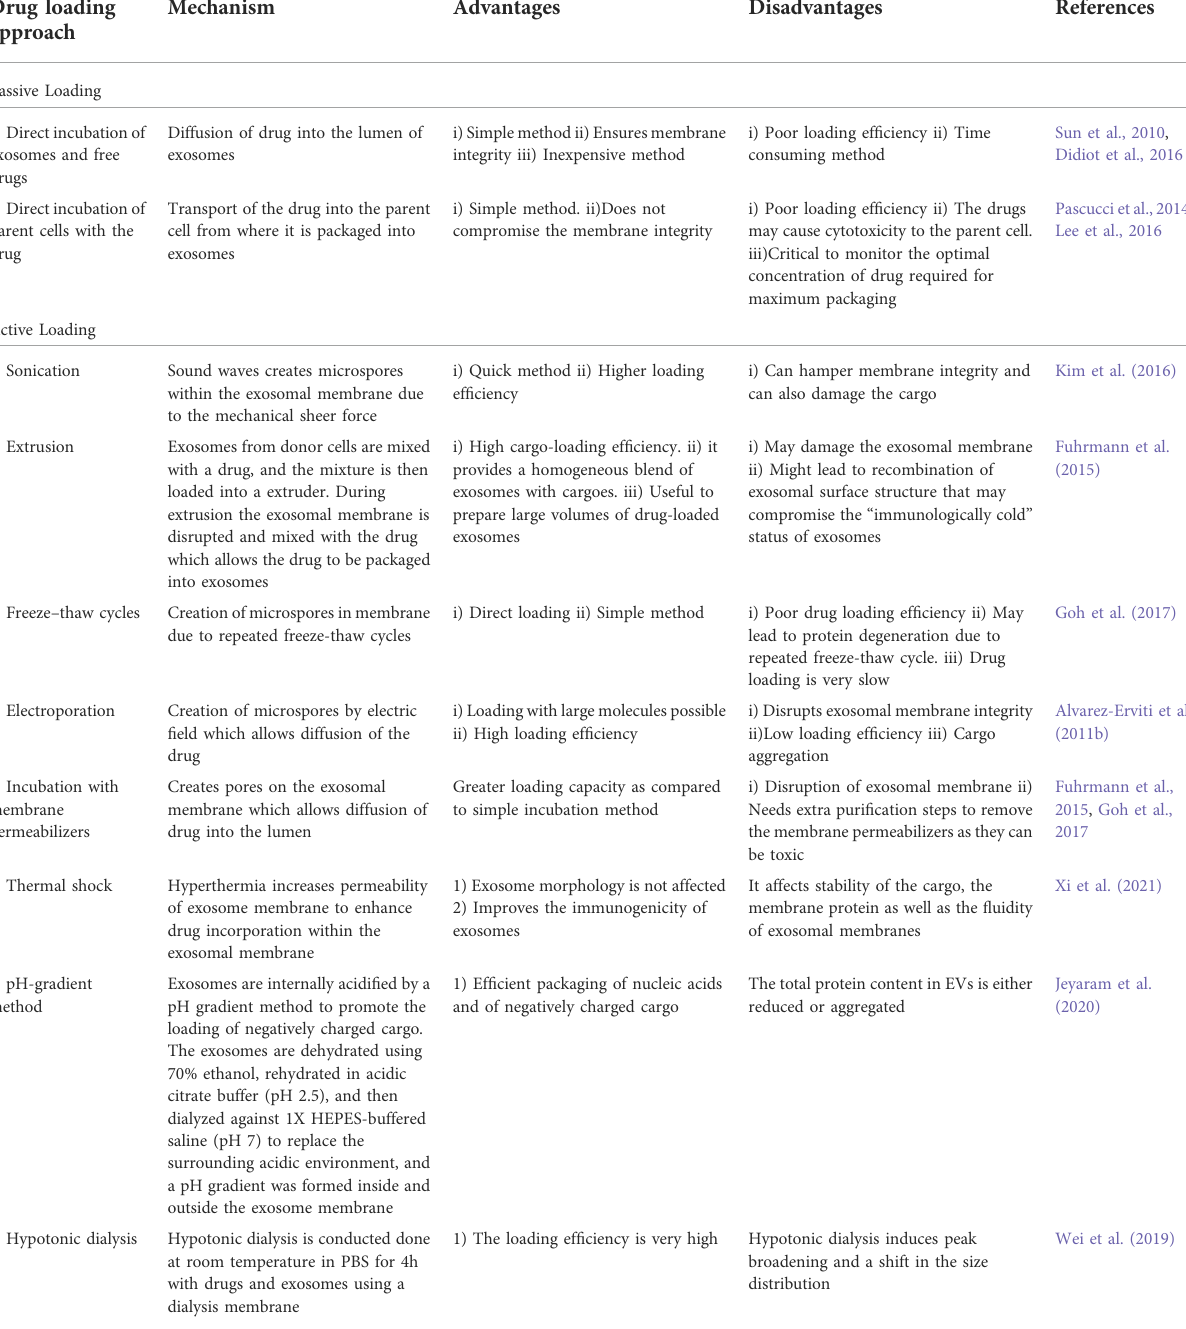
TABLE 2 Methods to load exosomes with drugs or other therapeutic